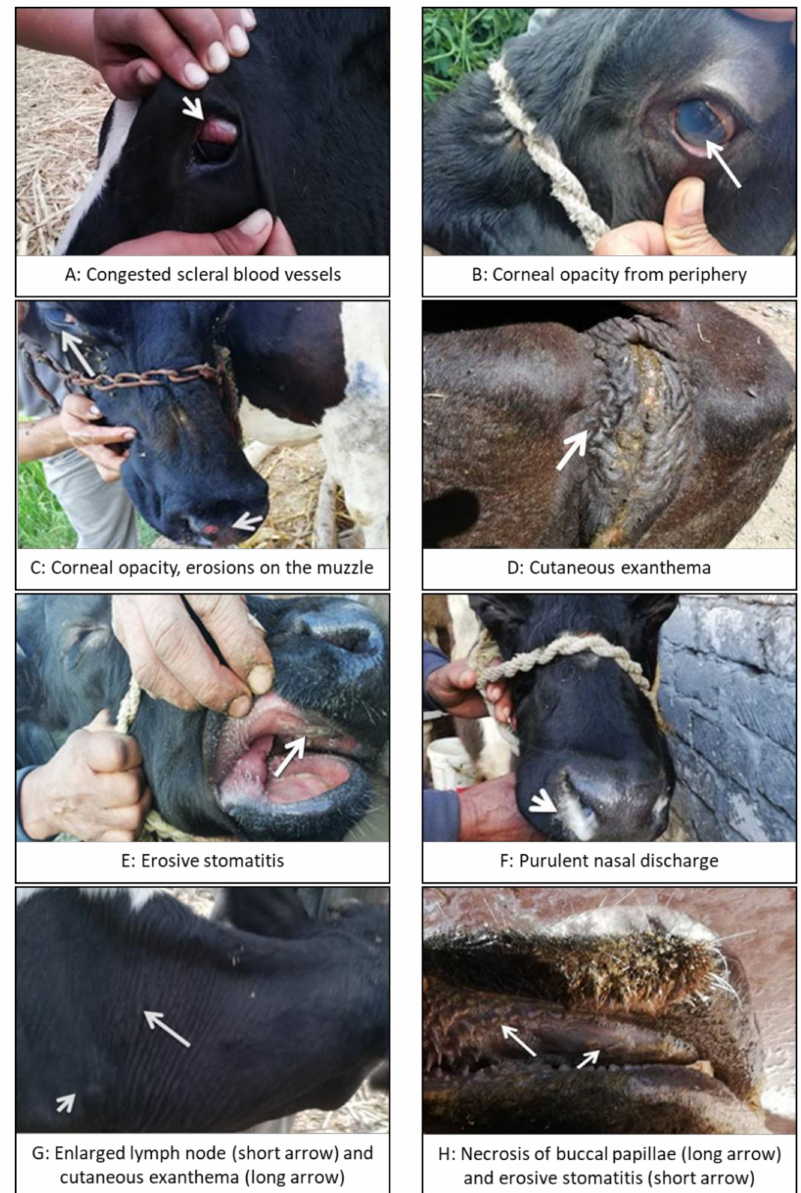
Figure 1. Clinical signs in malignant catarrhal fever (MCF)-a ff ected cattle. Gloves should be worn at all times when attending to diseased